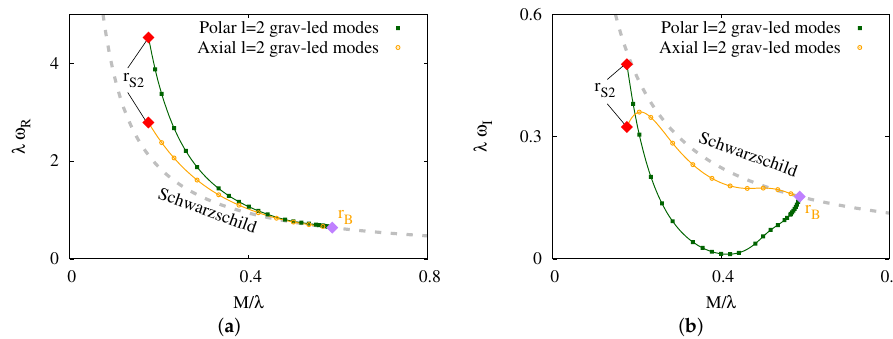
Figure 9. Polar and axial l = 2 QNMs of static spontaneously scalarized EsGB black holes with exponential coupling: ( a ) scaled frequency λω R vs. scaled mass M / λ ; ( b ) scaled decay rate λω I vs. M / λ . Additionally shown are the Schwarzschild modes, the bifurcation point from Schwarzschild r B , and the point r S2 , where hyperbolicity is lost for the axial modes